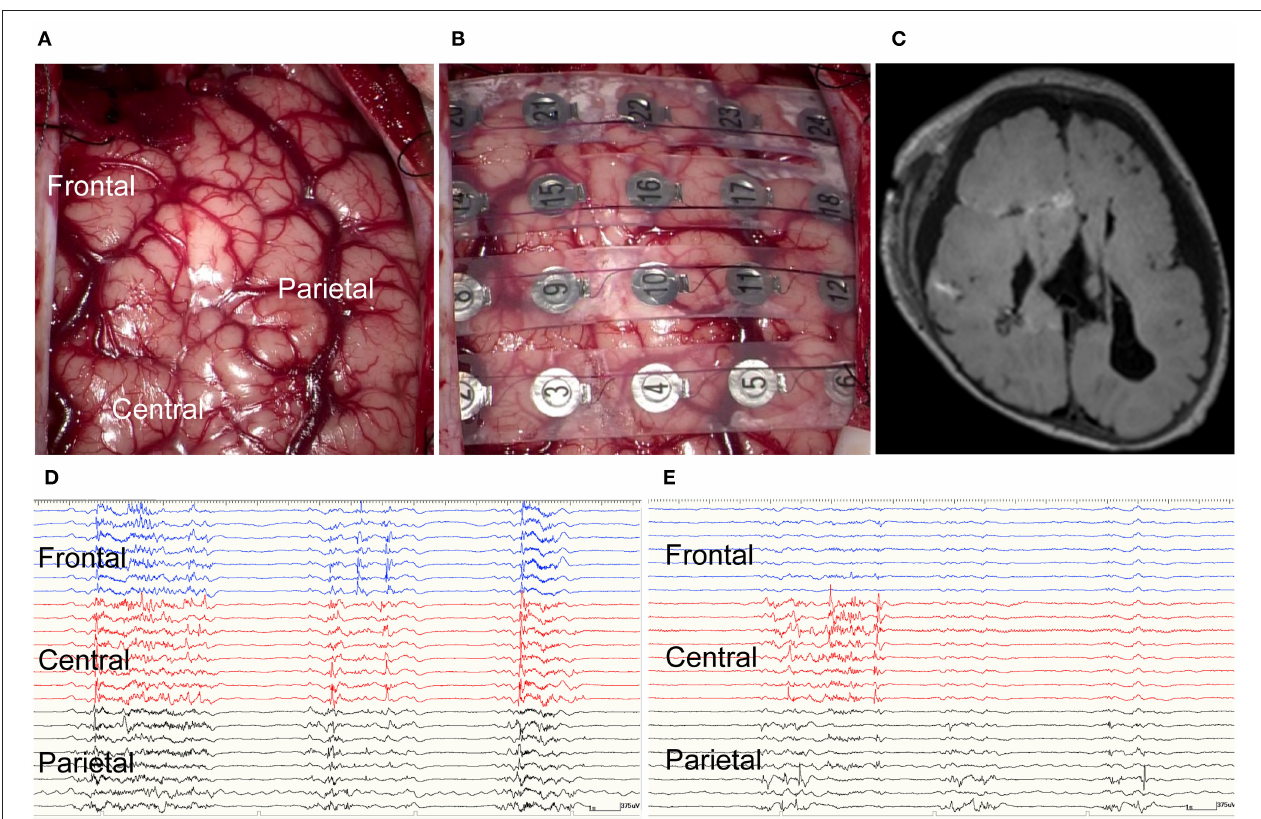
FIGURE 3 | Intraoperative electrocorticography and postoperative imaging. (A) Intraoperative findings included absent Roland vein and ambiguous central sulcus. The sclerotic cortex was identified in the central area. (B) Intraoperative electrocorticography. (C) Postoperative axial fluid-attenuated inversion recovery magnetic resonance imaging (FLAIR MRI) demonstrated the disconnection line. (D) Intraoperative electrocorticography before subtotal hemispherotomy. (E) Intraoperative electrocorticography after subtotal